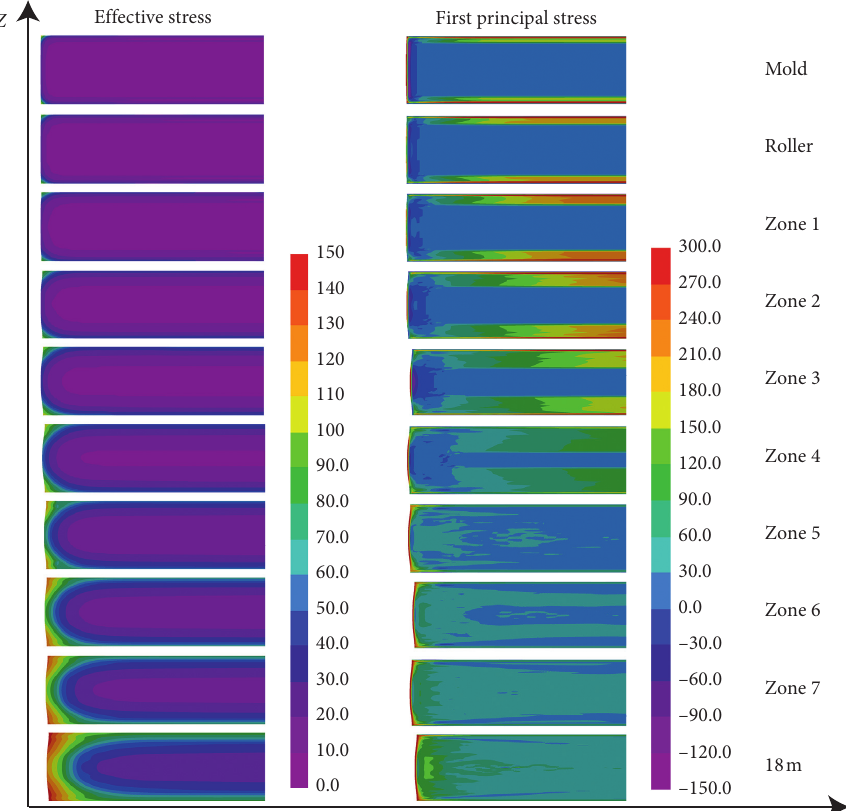
Figure 8: The cloud diagram of the effective stress and the first principal stress distribution on the cross section of the outlet of each zone.